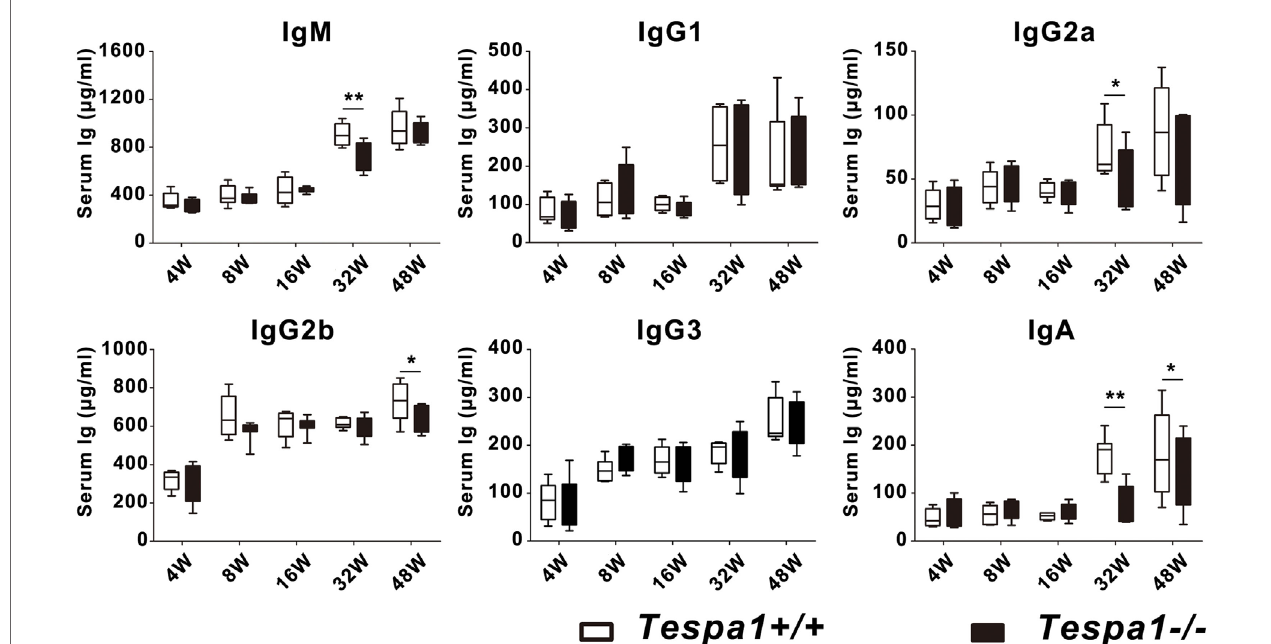
FigUre 2 | Aged Tespa1 -deficient mice have lower baseline serum antibody levels. Baseline serum Ig levels in Tespa1 -deficient and wild-type control mice of the indicated ages, measured by ELISA. Data are shown as the mean ± SEM with eight mice per group and are from one experiment representative of two performed. * p < 0.05, ** p < 0.01 (Mann–Whitney